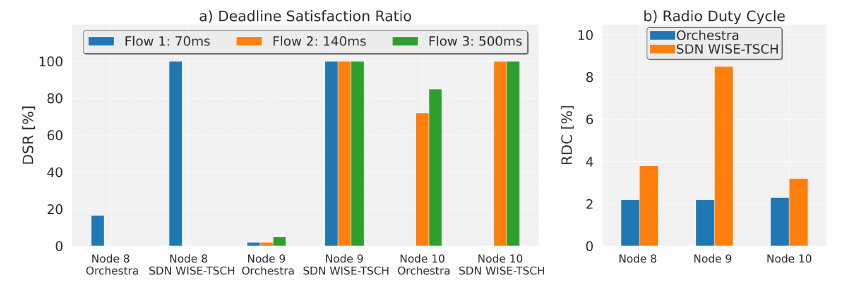
Figure 11. Deadline Satisfaction Ratio obtained in testbed for each Tx